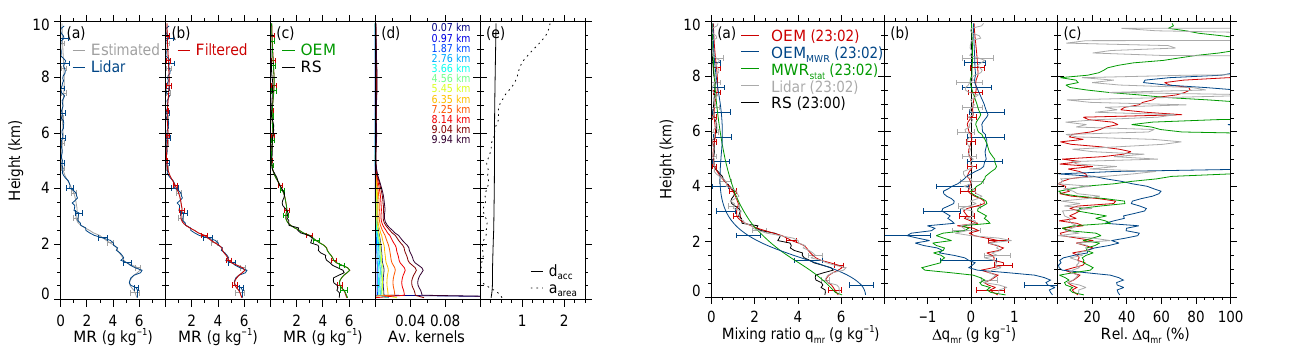
Figure 8. Overview of cloud-free scene on 5 May 2013, 23:02UTC. Mixing ratio (MR) profiles from the Raman lidar and the esti- mated (a) , the Kalman-filtered (b) and the optimally estimated state (c) . Additionally, the mixing ratio of the radiosonde (RS) is shown (c) . Error bars are added to the profiles at the different states of the processing. (d) Averaging kernel for a subset of 10 levels indi- cated by the coloured numbers. (e) Accumulated degree of freedom d acc (solid) and the area of the averaging kernel A area (dotted).